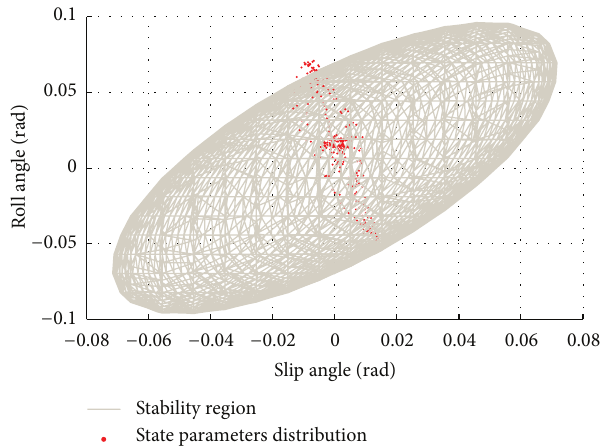
Figure 10: Details of vehicle’s dynamic parameters’ distribution.